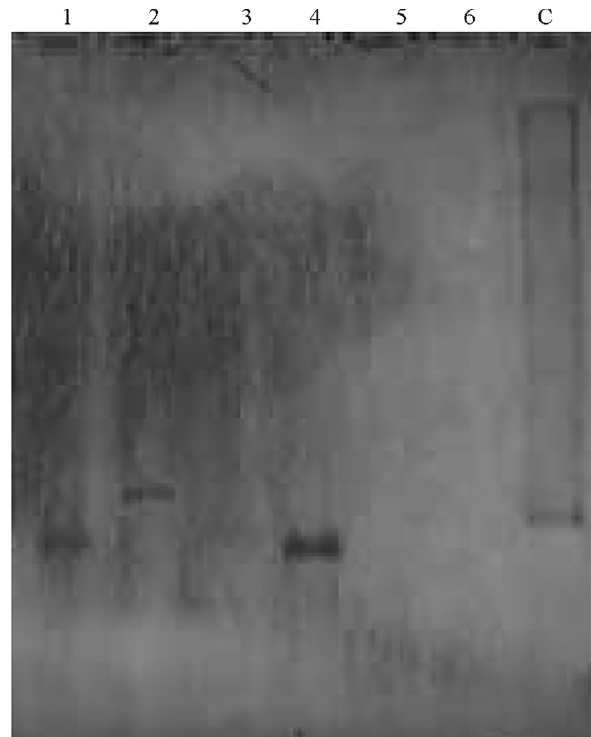
Figure 4 - Southern blotting analysis of the wsp gene using genomic DNA from different Wolbachia infected silkworms. The blot was hybridized with a probe corresponding to the wsp gene. Lane C represents a positive control from plasmid DNA of a recombinant wsp gene. Lanes 1-3 repre- sent wild silkworm samples from Huzhou, Xichan and Pingdu, respec- tively. Lane 4 represents F1 silkworms from a Male Dali x Female Dazao cross. Lanes 5 and 6 represent female and male samples of the Dazao strain,